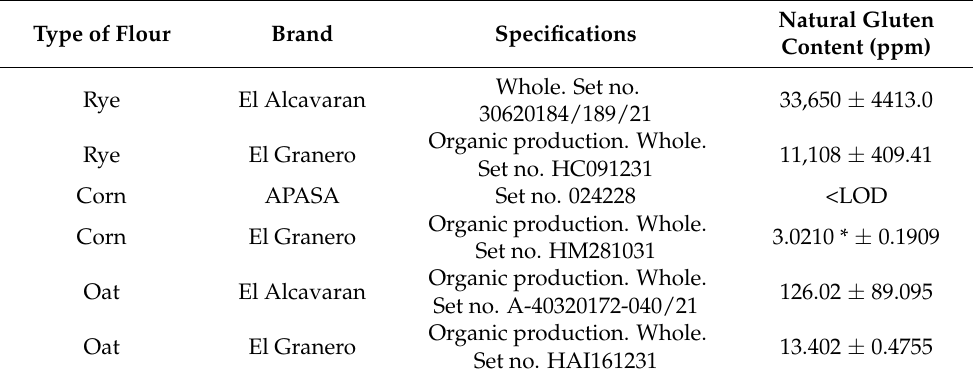
Table 1. The specifications and natural gluten content of the commercial flours used for the prepa ‐ ration of the samples.